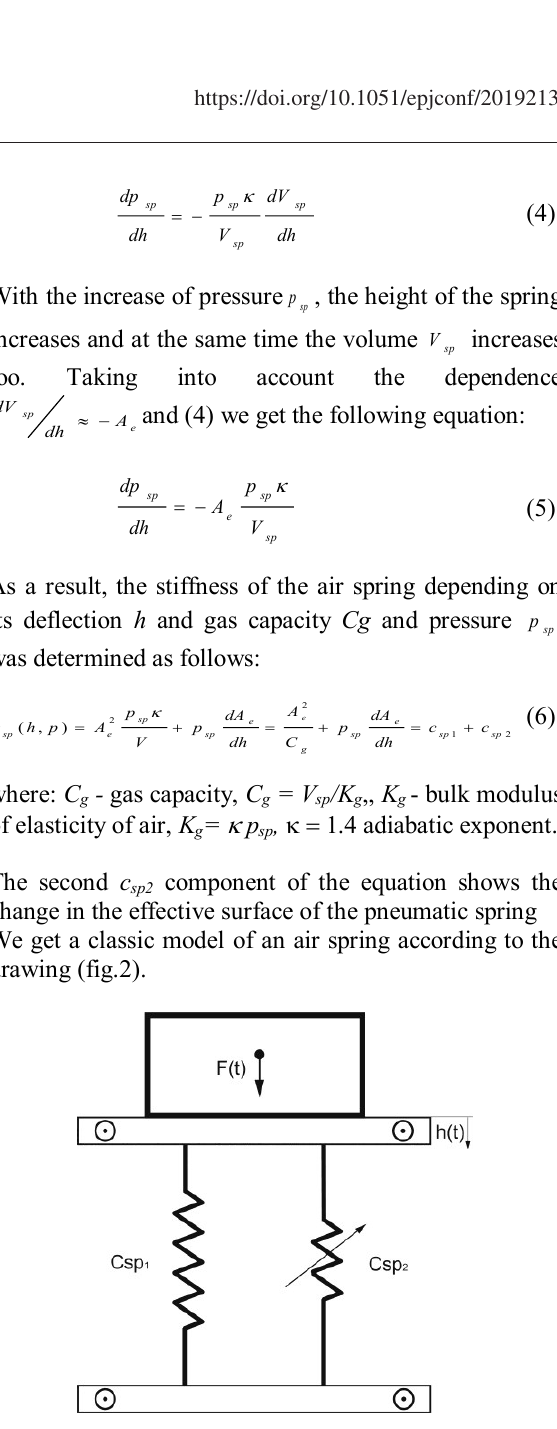
Fig.2. Air spring